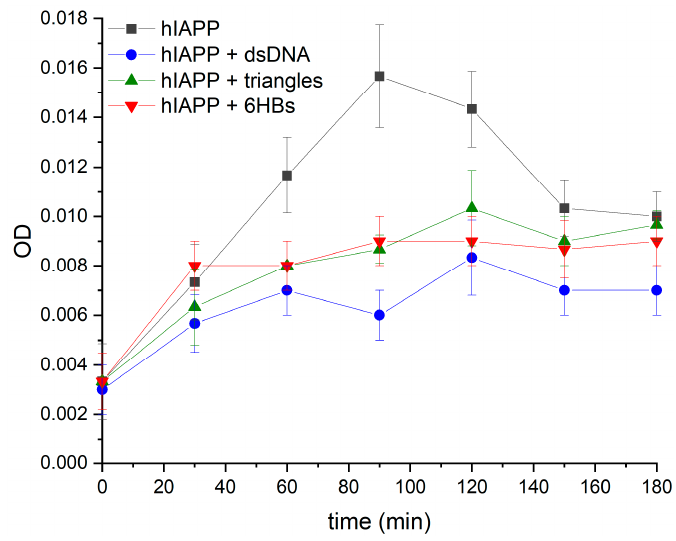
Figure 2. Optical density (OD) at 600 nm of human islet amyloid polypeptide (hIAPP) with and without different DNA structures as a function of incubation time.